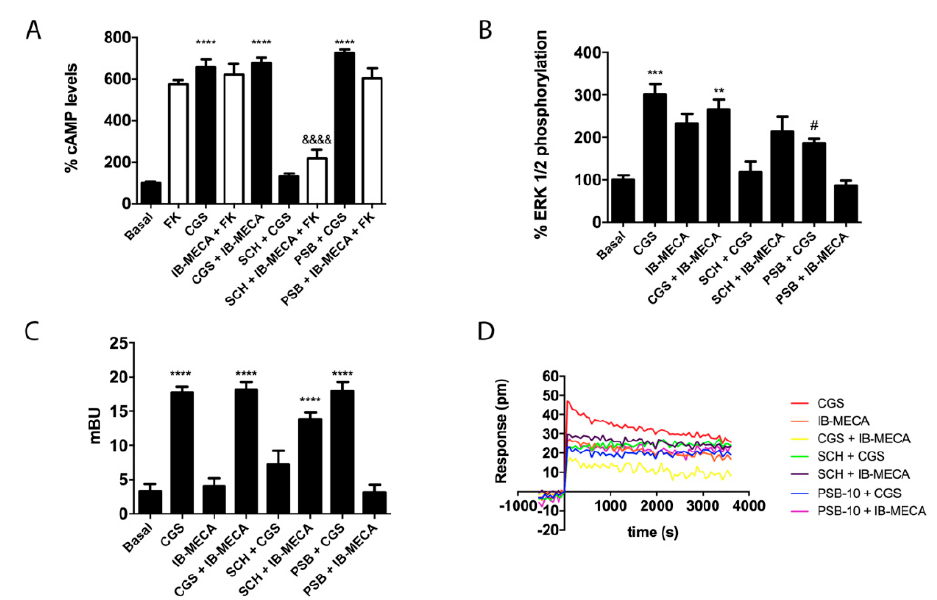
Figure 3. Signaling assays in HEK-293T cells expressing A 2A R/A 3 R-Hets. HEK-293T cells expressing A 2A R (0.3 µg cDNA) and A 3 R (0.4 µg cDNA) were pretreated with selective receptor antagonists (1 µM SCH 442416 for A 2A R or 1 µM PSB-10 for A 3 R) and subsequently treated with selective agonists (100 nM CGS 21680 for A 2A R or 100 nM IB-MECA for A 3 R). cAMP accumulation ( A ) was determined by HTRF as described in Methods. When indicated, cells were subsequently treated for 15 min with 0.5 µM forskolin. ERK1/2 phosphorylation ( B ) was analyzed using an AlphaScreen ® SureFire ® kit (Perkin Elmer) and β -arrestin 2 recruitment ( C ) was determined by BRET. ERK1/2 phosphorylation and β -arrestin 2 recruitment data are expressed as increases in percentage over basal, whereas cAMP data are expressed as percentage with respect to values obtained with forskolin. Dynamic mass redistribution (DMR) tracings ( D ) represent the picometer-shifts of reflected light wavelength over time. All data are the mean ± S.E.M. of eight different experiments performed in triplicates. In cAMP (in the absence of forskolin), ERK1/2 phosphorylation, and β -arrestin 2 recruitment assays, one-way analysis of variance (ANOVA) followed by Bonferroni’s multiple comparison post hoc test were used for significance analysis. * p < 0.05, ** p < 0.01, *** p < 0.001, and **** p < 0.0001 versus vehicle treatment (basal); # p < 0.05 significance versus agonist treatment; &&&& p < 0.0001 versus forskolin treatment.